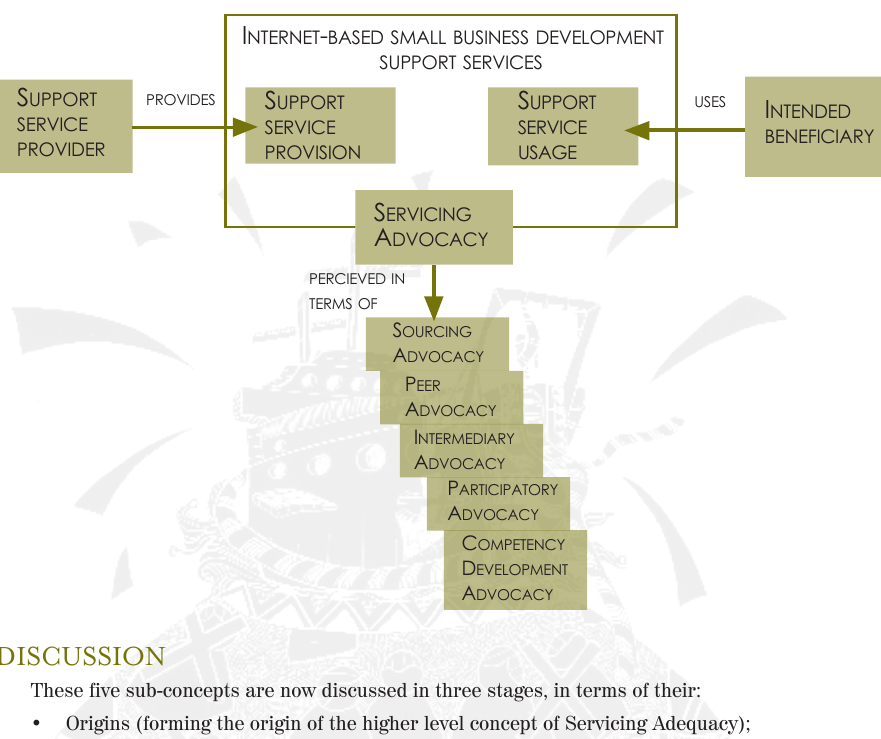
FIGURE 2: SERVICING ADVOCACY AND ITS